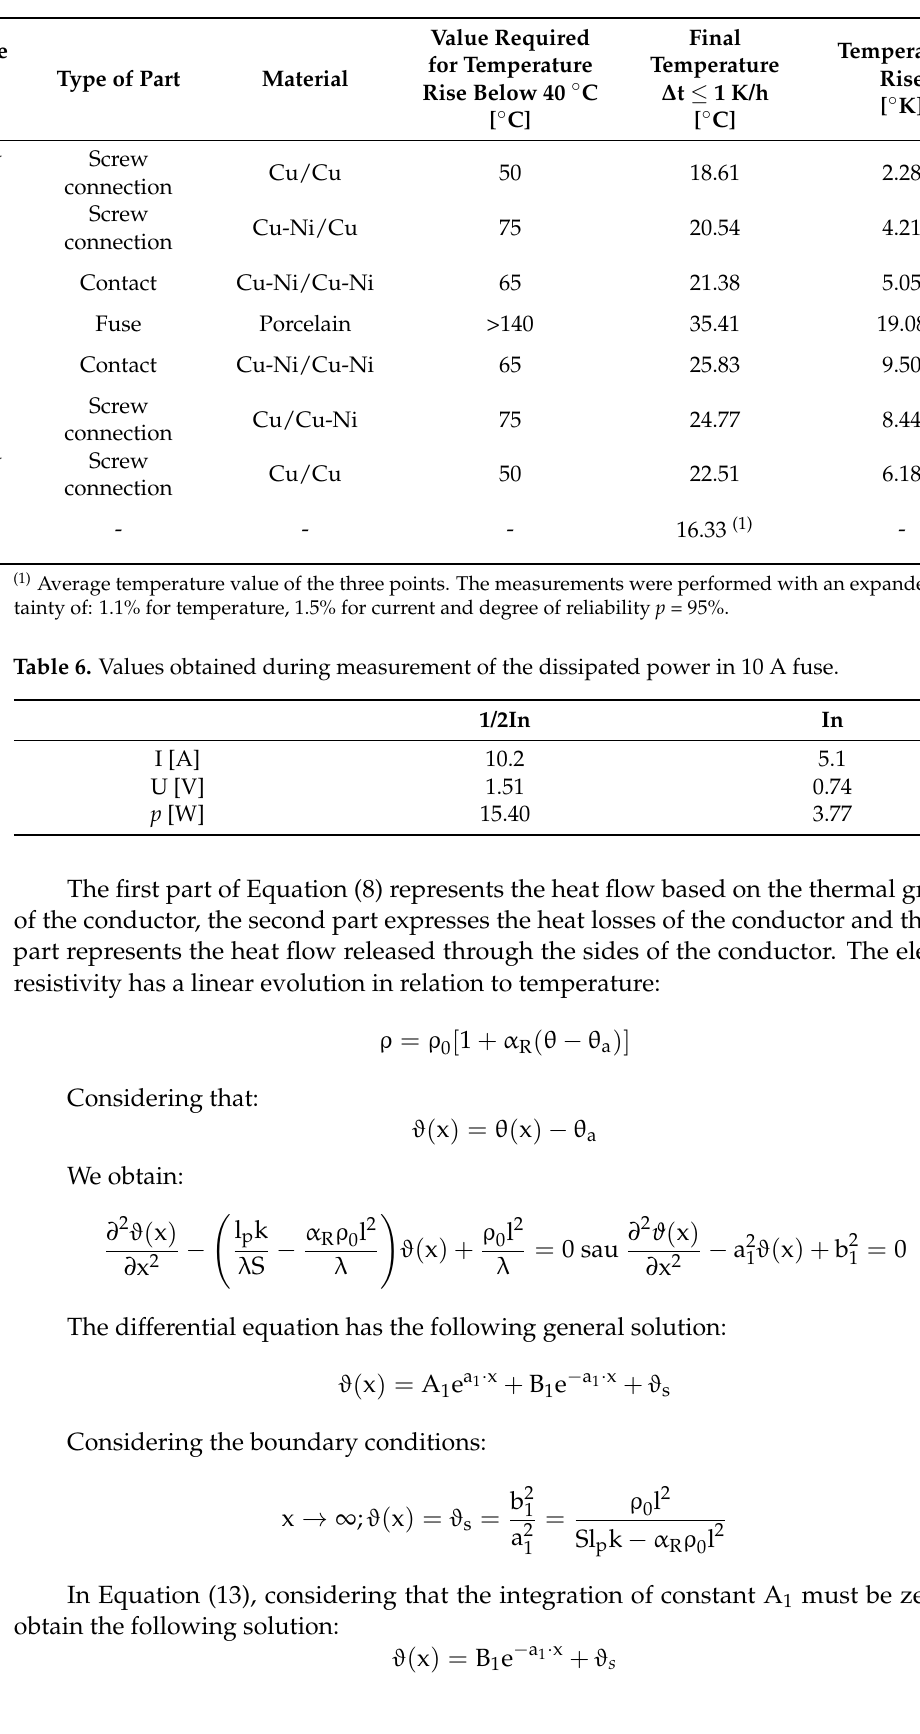
Table 5. Values obtained during temperature-rise experiments on 10 A fuse.